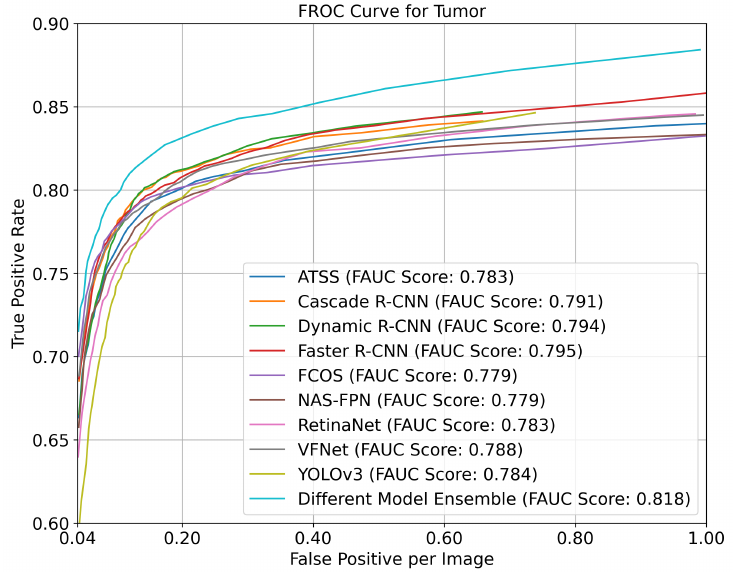
Figure 4. FROC curve for the pathological region for the best different model strategy on the BraTS 2020